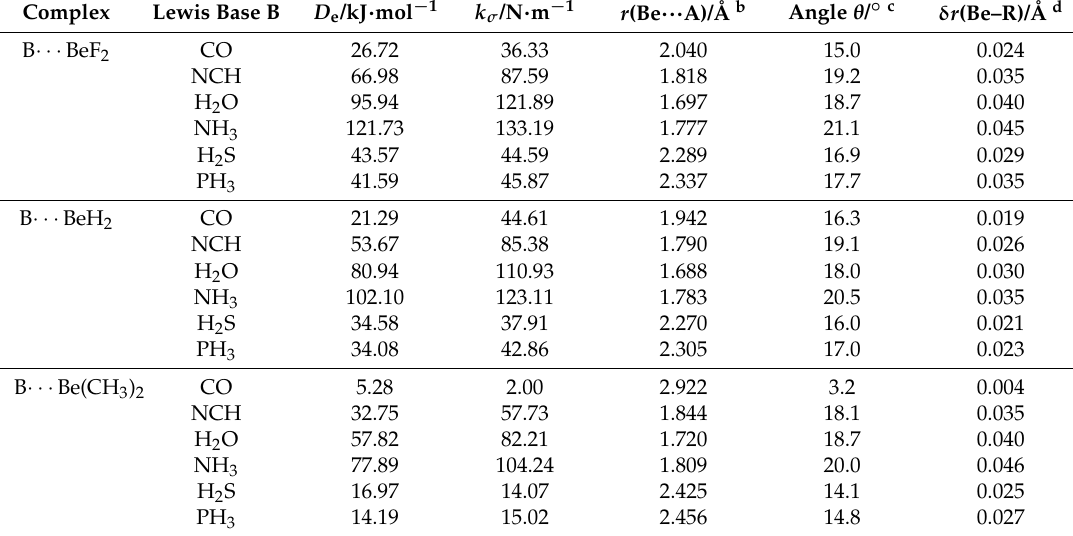
Table 1. Some ab initio calculated properties of the B ··· BeR 2 complexes (R = F, H orCH 3 ) for six different Lewis bases B a .